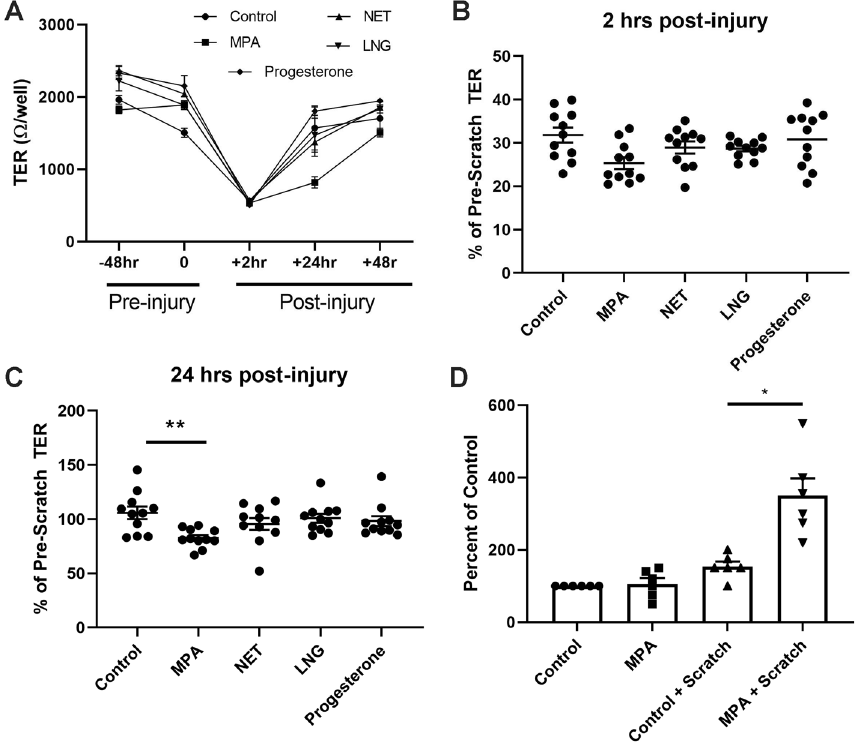
Figure 2. MPA decreases barrier integrity and increases paracellular permeability of endometrial epithelial cells treated with MPA. (A) Representative transepithelial resistance (TER) profile of endometrial epithelial cells grown in transwell inserts pre- and post-scratch during exposure to 100 nM MPA, NET, LNG, or Progesterone. Scratch was performed at 0 h. Each symbol represents the mean + /− SEM from a single time point. Data shown is from a representative patient. (B) TER of endometrial epithelial cells grown in transwell inserts 2 h and (C) 24 h following scratch treated with 100 nM MPA, NET, and LNG. Each symbol represents a single individual ( n = 11 ). (D) FITC-Dextran 4KDa flux assay 24 h post-scratch performed over 6 h. Cells were treated with MPA, NET, or LNG at 100 nM for 48 h prior to scratch, and maintained in cell culture media at 100 nM post-scratch. Bars represent mean + /− SEM. Each symbol represents a single individual ( n = 6 ). Values are normalized to the control unscratched condition which is set to 100. *p < 0.05; **p <